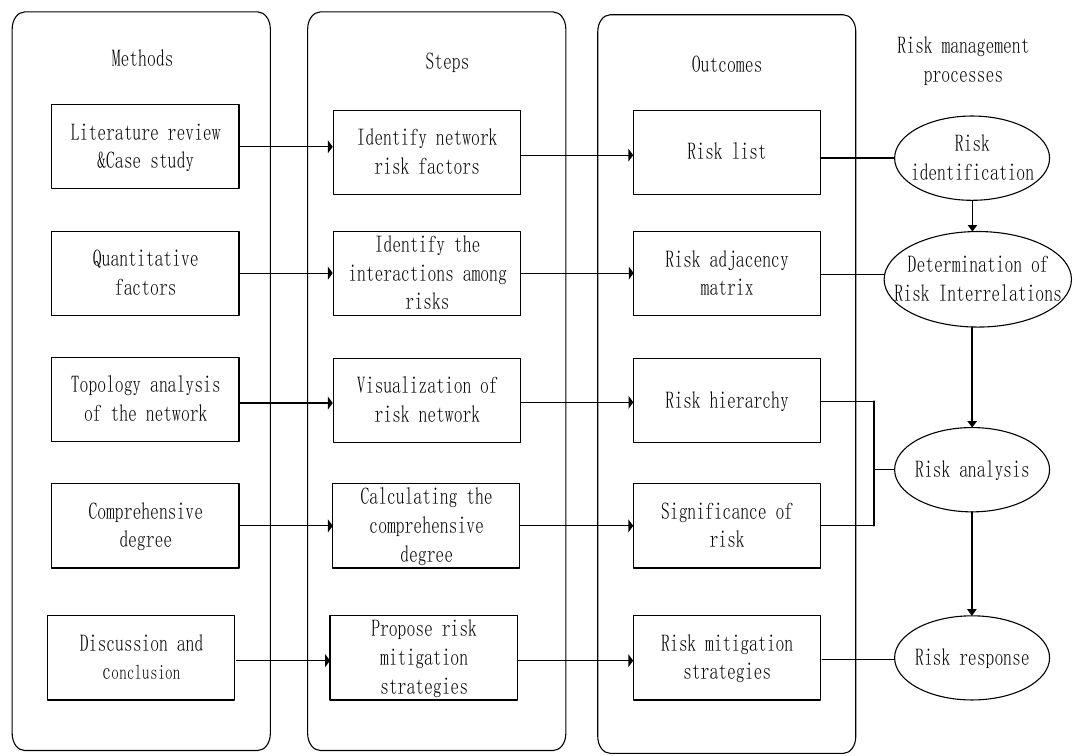
Figure 1. Research framework of risk management approach.